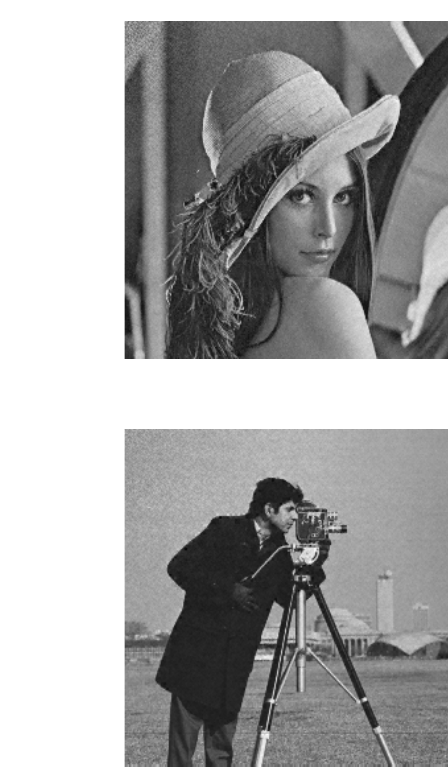
Figure 3. The images from Table 1 and their corresponding transformations with each method. From left to right: the image produced by the Zebbiche JND model and the image produced by the modulated Zebbiche JND model.